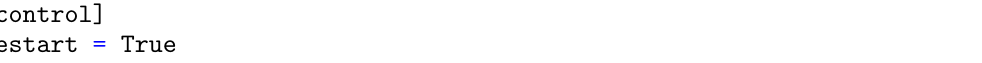
Figure 7: Renormalization factor z as a function of the number of bath sites N computed by the pomerol solver. The blue line shows the CT-QMC result z = 0.58. is plotted as a function of the iteration number (left panel). z is bounded in the range 0 < z ≤ 1. The right panel shows the difference of the renormalization factor between the i -th and ( i − 1 ) - th iterations. The graph shows an exponential decay. The loop is terminated at the 13th iteration, where the difference falls below converge_tol = 1e-5